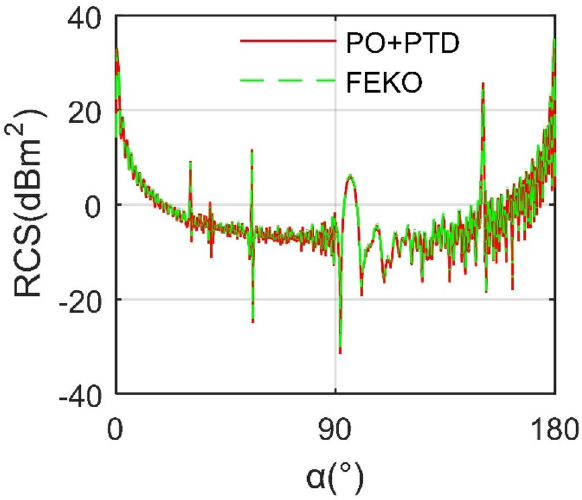
Figure 3. Verification of RCS calculation method on m 0 , β = 0°, f R = 10